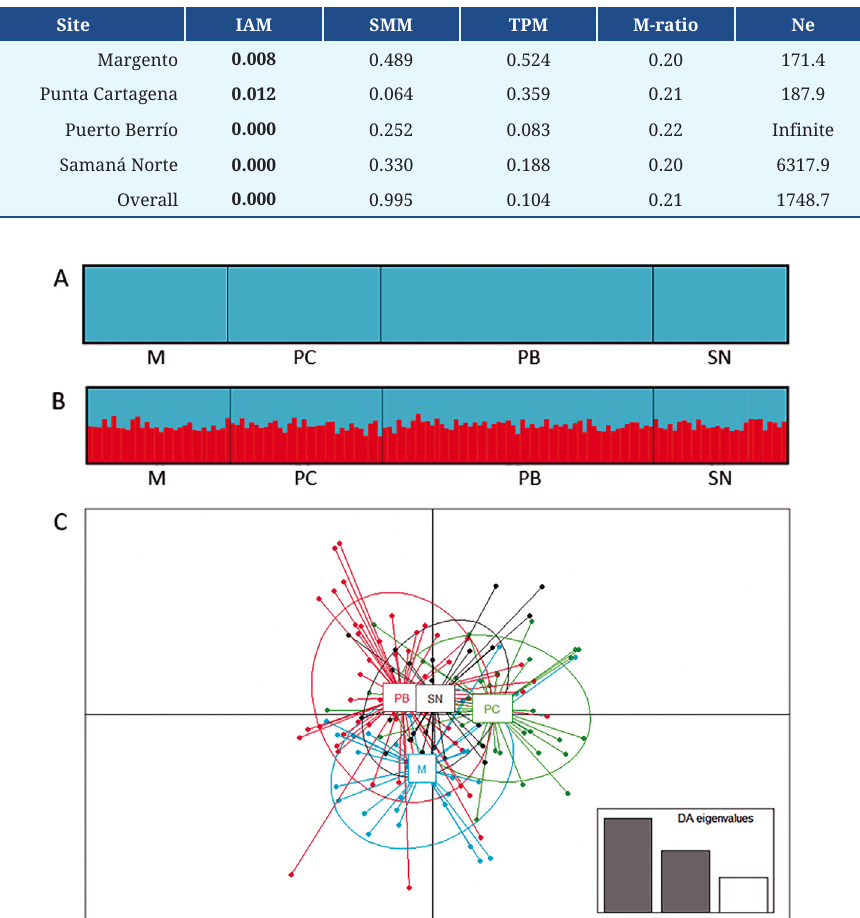
FIGURE 2 | Results of Structure ( A , B ) and Discriminant analysis of principal components ( C ) for Pseudoplatystoma magdaleniatum . A: K = 1; B: K = 2; M: Margento, PC: Punta Cartagena, PB: Puerto Berrío, SN: Samaná Norte.